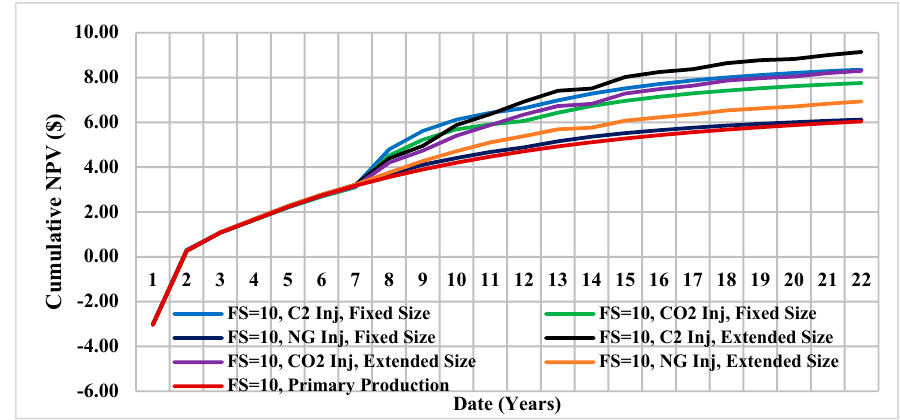
Figure 28. NPV of the scenarios for fixed and extended cycles of cyclic CO2, C2 and NG injection as well as natural depletion, FS=10, Oil API=31.